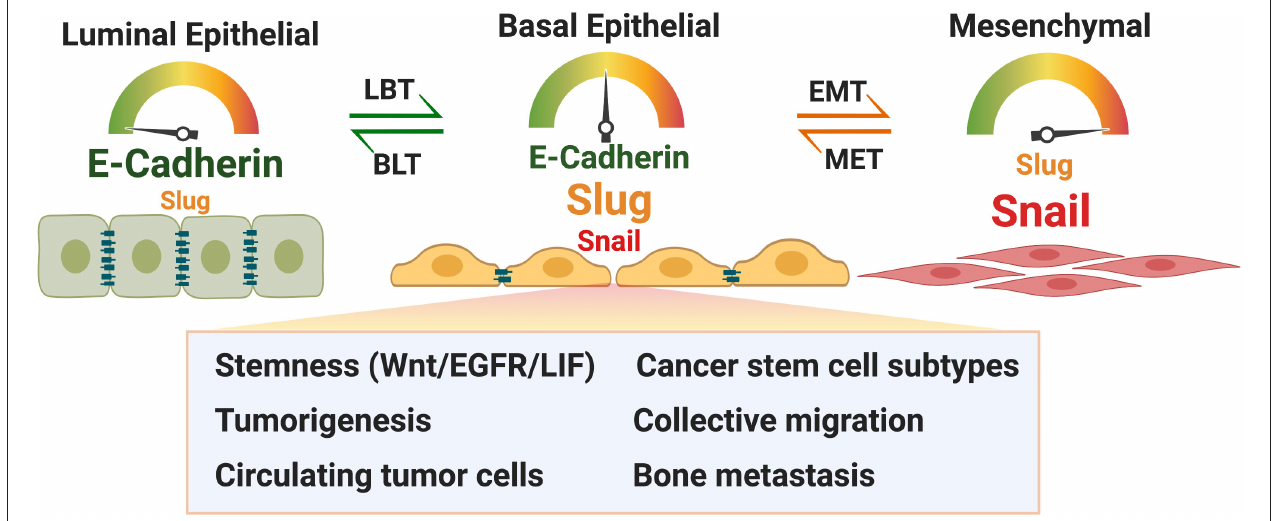
FIGURE 2 | Model describing expression of E-cadherin and Slug in luminal epithelial, basal epithelial and mesenchymal cancer cells and the proposed qualities of basal epithelial cancer cells due to co-expression of Slug and E-cadherin. Luminal basal transition (LBT) and basal luminal transition (BLT) are proposed terminologies in addition to EMT and MET. See text for details. Figure was created with